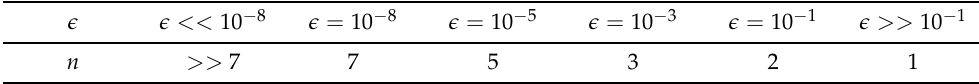
Table 2. Applying the FPA to find n for various (cid:101) and x = 0.2.